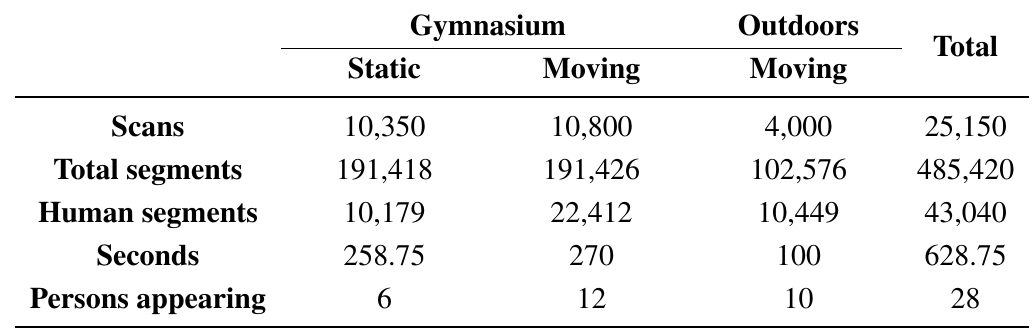
Table 3. Overview of the acquired data set. Three scenarios in two different places were collected in